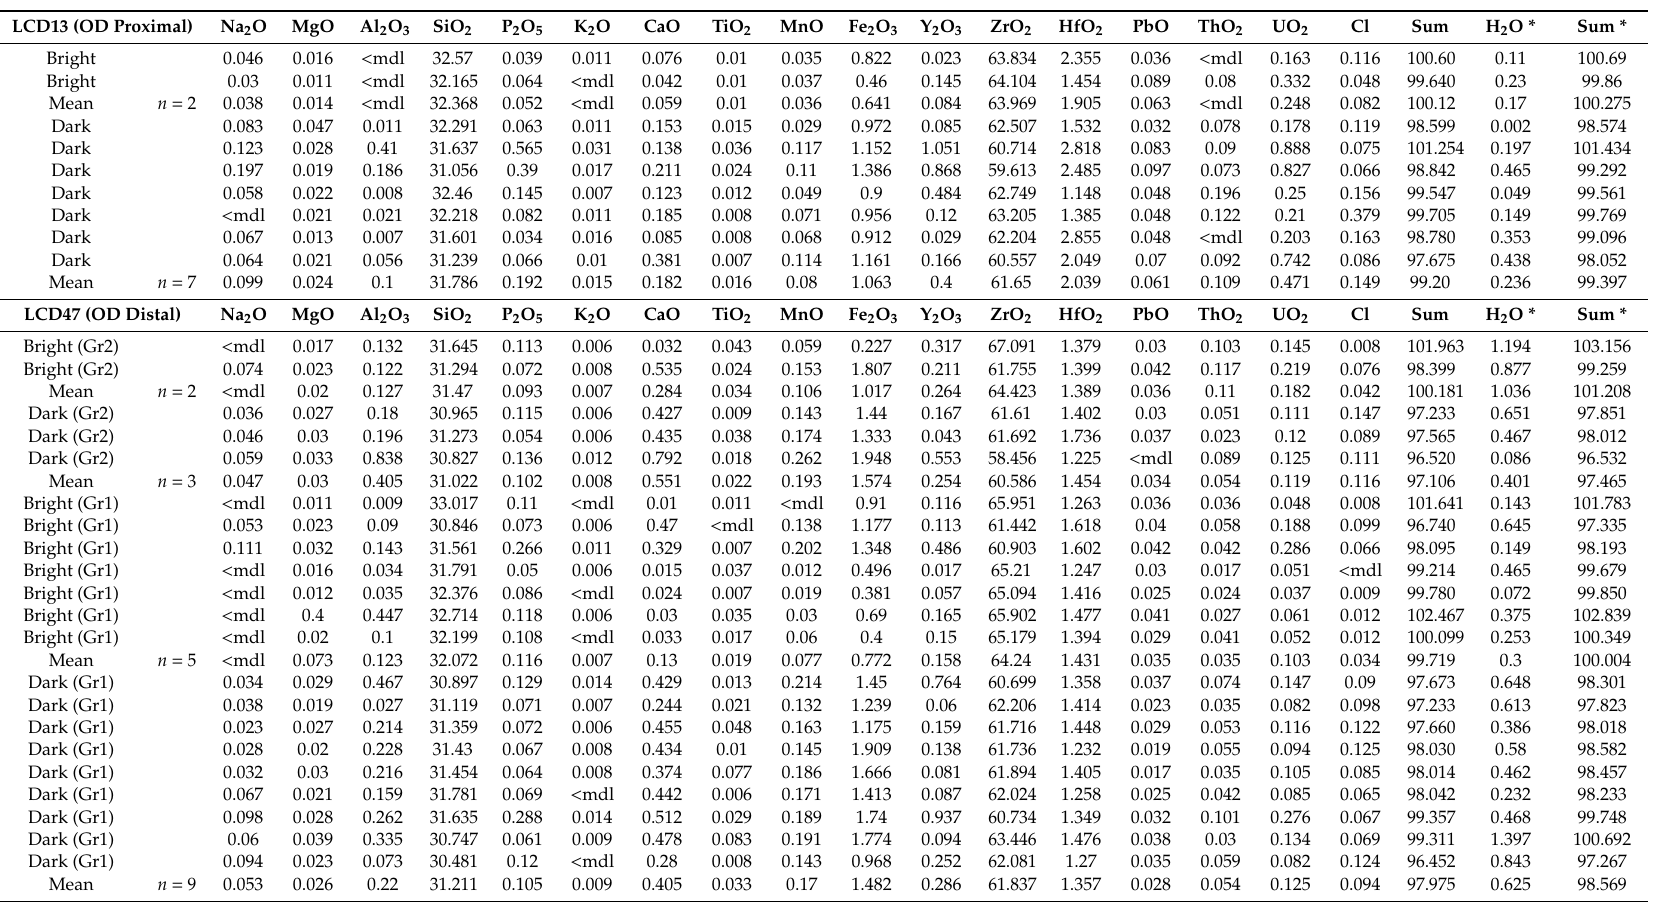
Table 2. EPMA zircon spot analyses. Gr1: grain 1; Gr2;